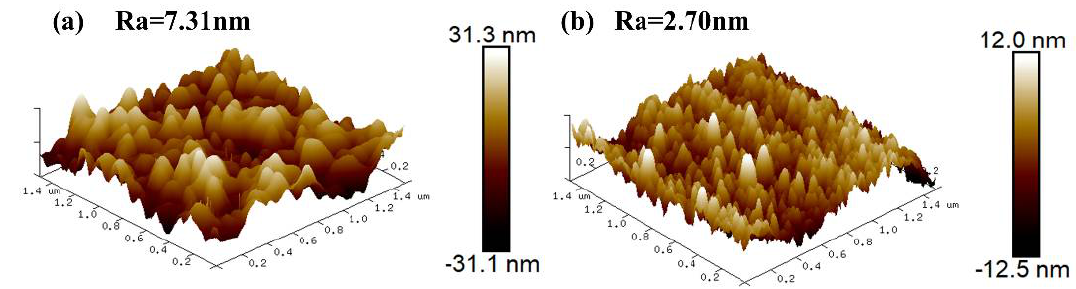
Figure 4. AFM three-dimensional diagrams of ( a ) HEA film and ( b ) HEN film.